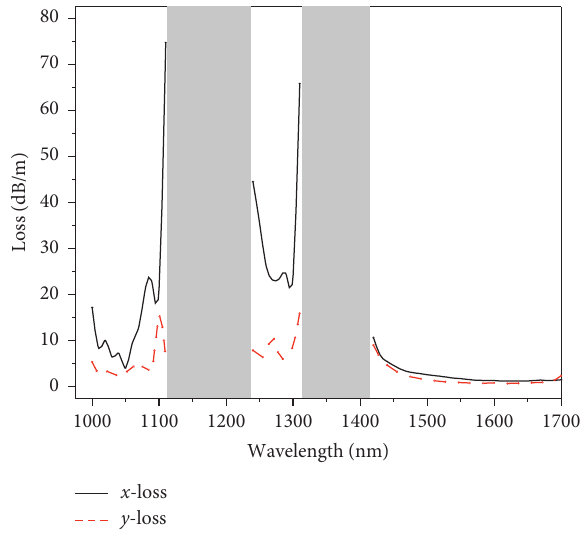
Figure 2: Loss of x polarization mode and y polarization mode as a function of